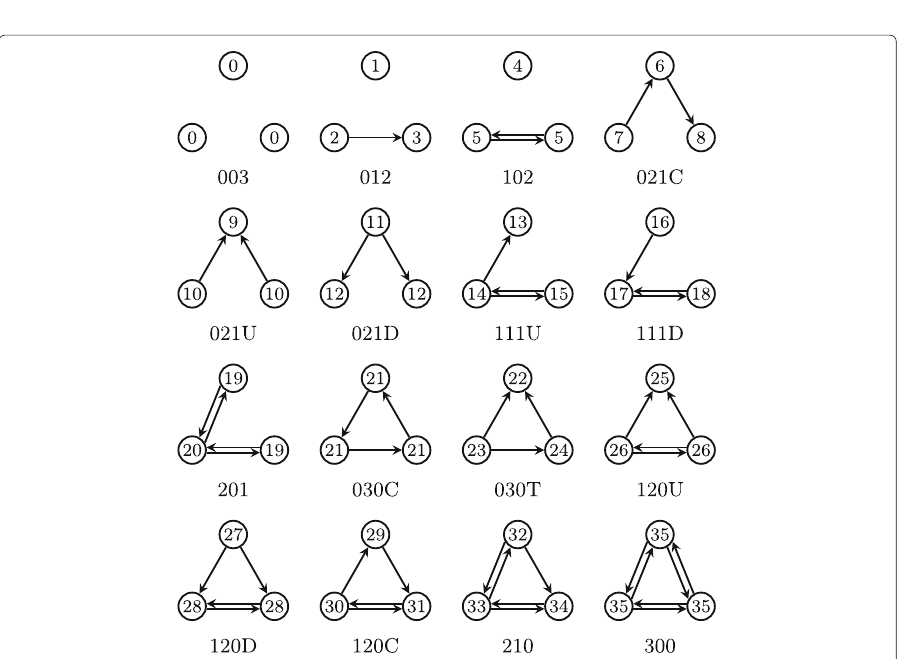
Fig. 7 All directed non-isomorphic subgraphs with three nodes (triads). The graph labeling is based on the number of mutual, asymmetric, and null dyads in each triad with an additional indicator where needed (Wasserman and Faust 1994). Node labels refer to the orbits and were enumerated such that each orbit is identified with a single